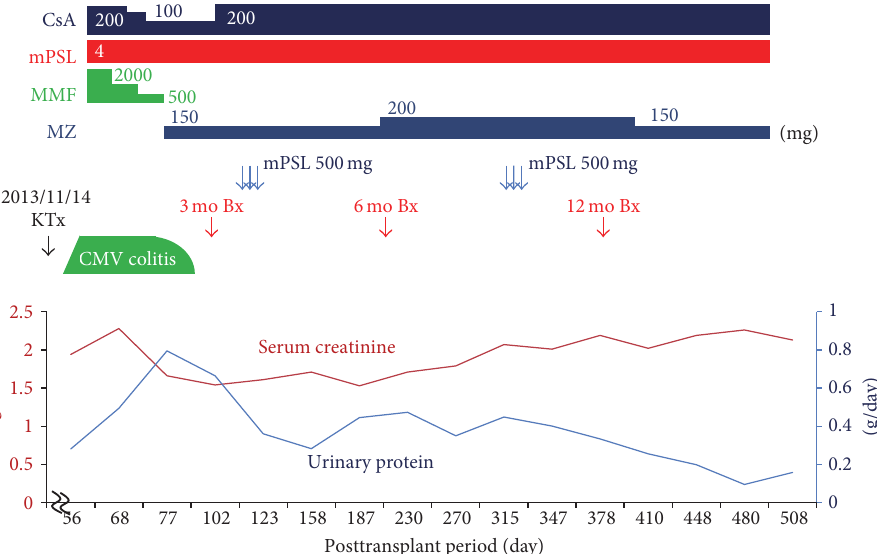
Figure 1: Clinical course. CsA: cyclosporine; MMF: mycophenolate mofetil; mPSL: methylprednisolone; MZ: mizoribine; CMV: cytomegalovirus; KTx: kidney transplantation; Bx: kidney